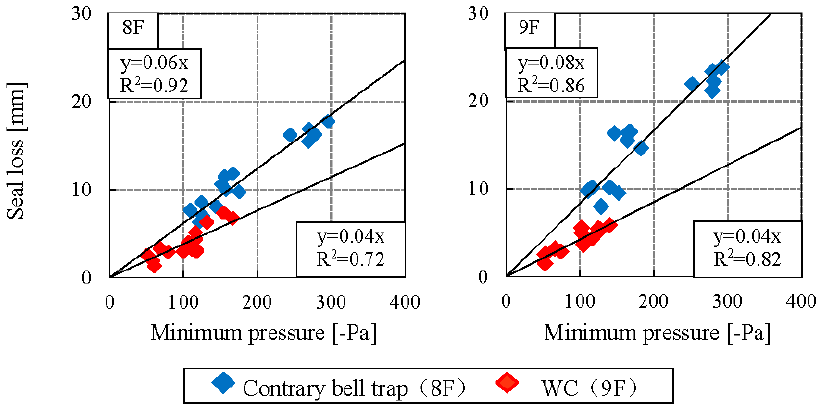
Figure 10. Seal loss on each floor for each discharge type.